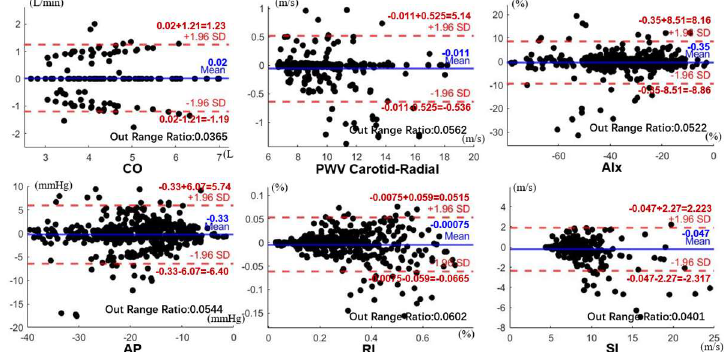
Figure 11. The Bland-Altman plot of six cardiovascular parameters.